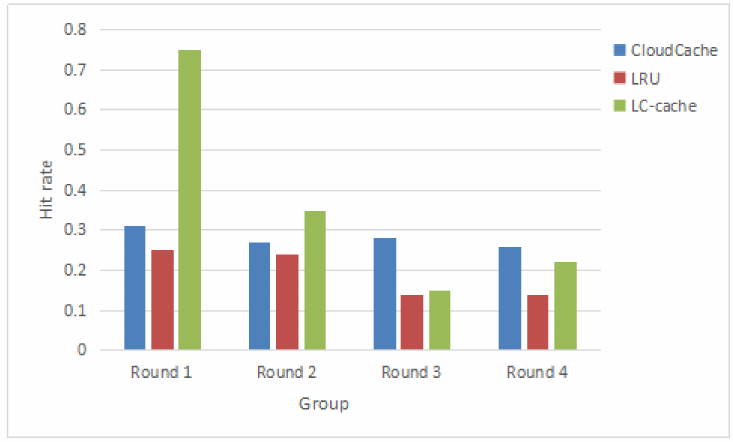
Figure 8. Cache Hit Rate